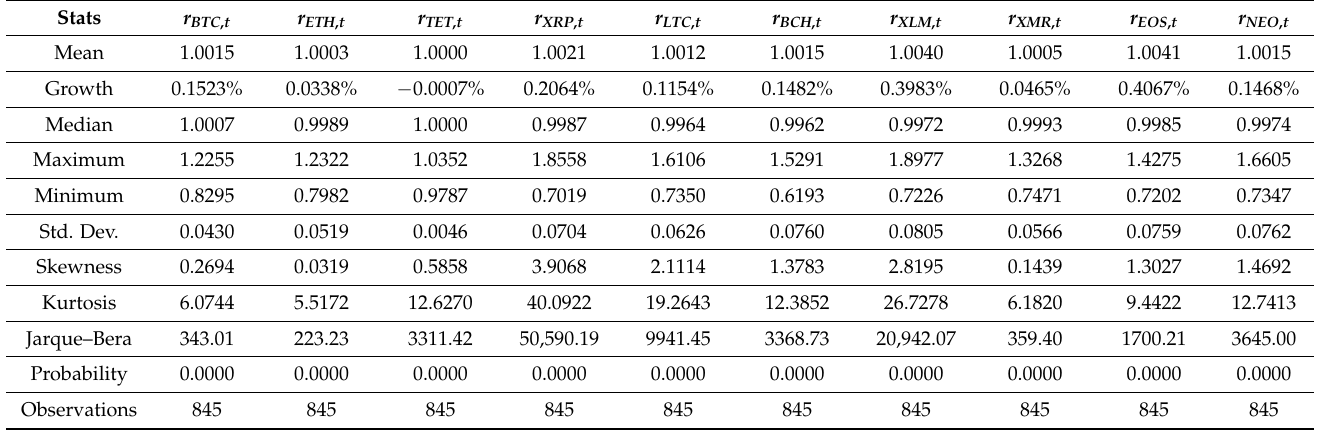
Table 3. Descriptive statistics of the 10 cryptocurrencies’ return indices for the pre-COVID-19 period.